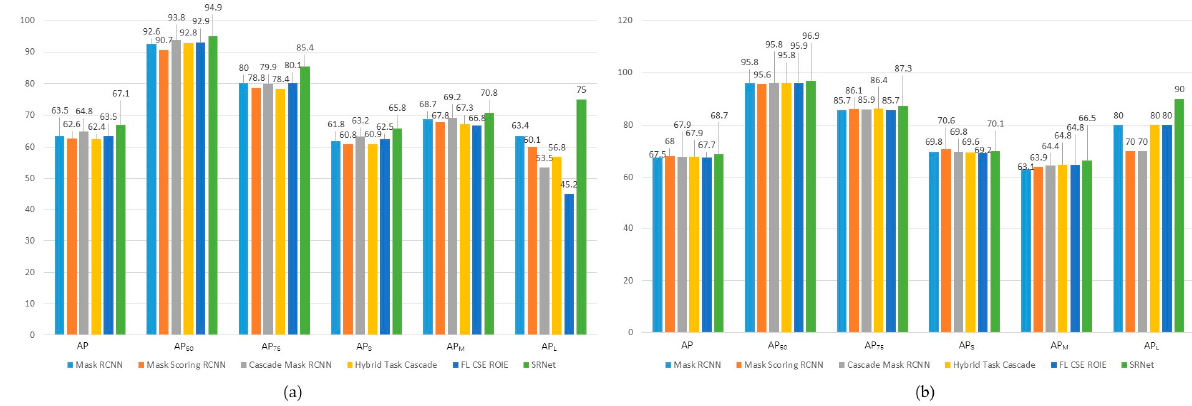
Figure 13. The histograms of instance-segmentation performance on the SSDD dataset ( a ) and the Instance-RSDD dataset ( b ).